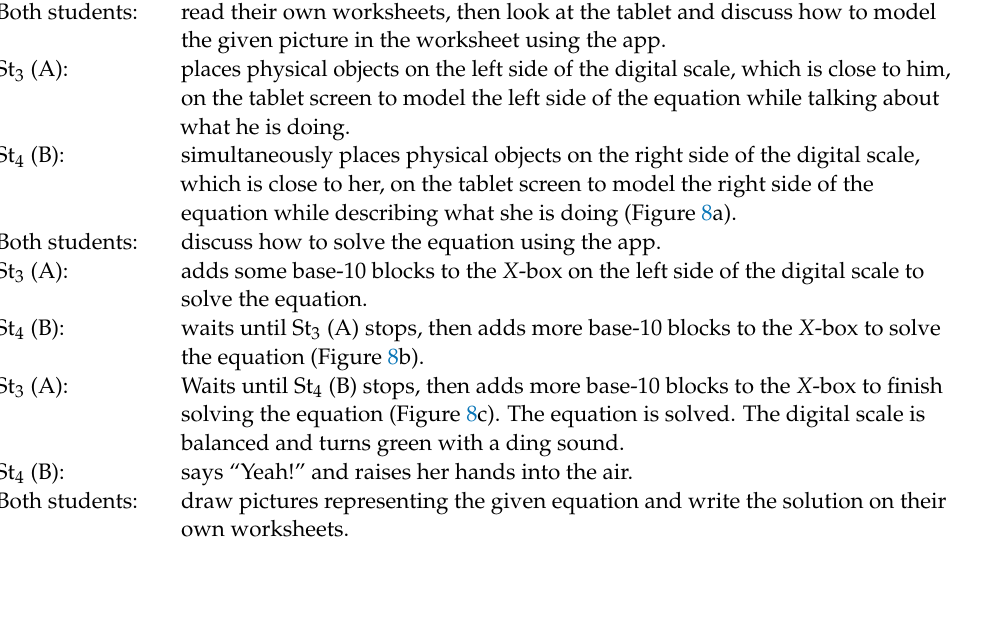
equation with the app while St 16 (B) is watching what St 15 (A) is doing.